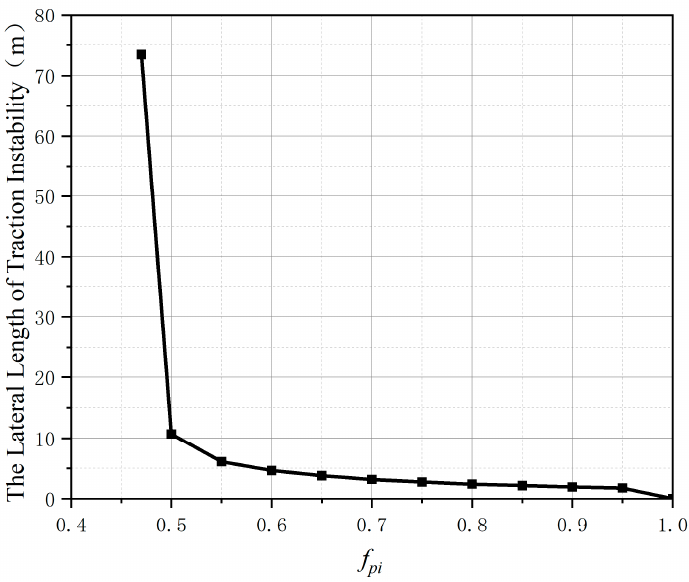
Figure 16. Influence of f pi on the lateral length of traction instability.